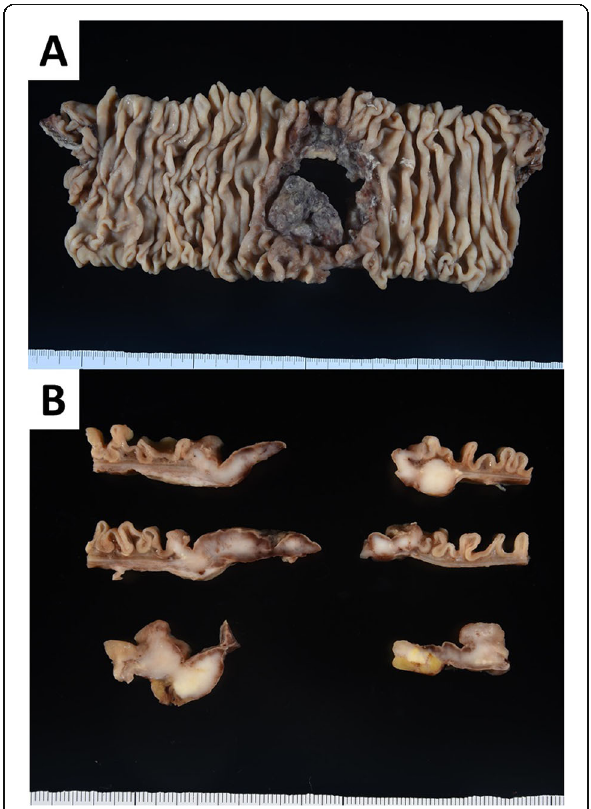
Fig. 2 The resected small intestine of perforation site with lung adenocarcinoma metastasis. a There was about 5 × 4 cm perforation site with fibrotic change. b White tumors were found in the section of the small intestinal perforation